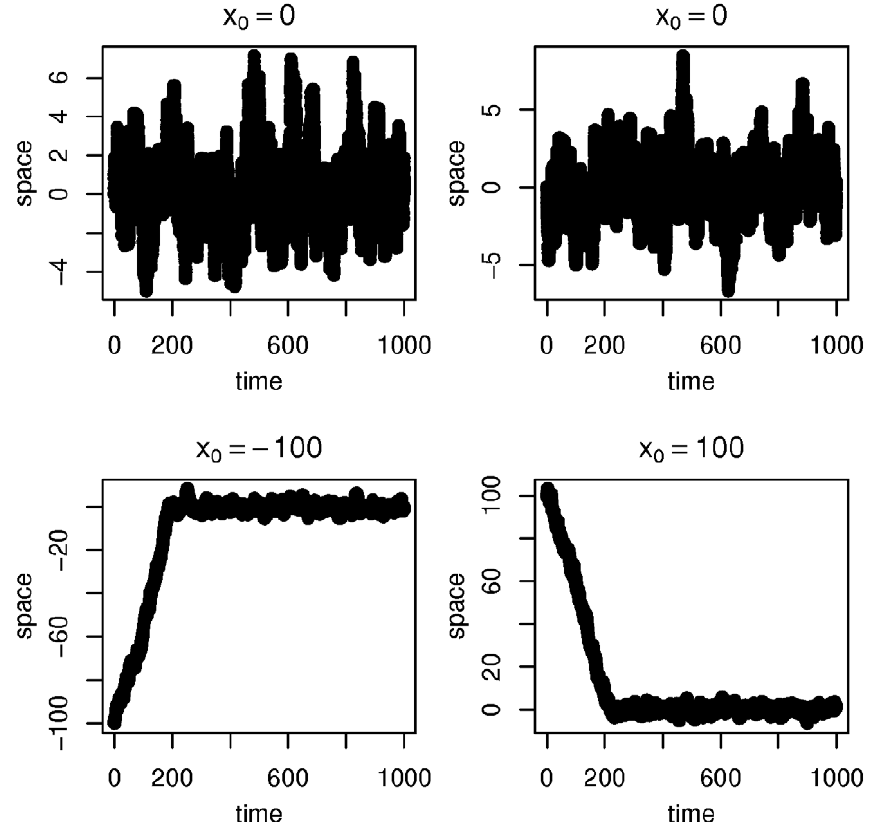
1 arctan x ð Þ . The process features mean reversion to 0. p